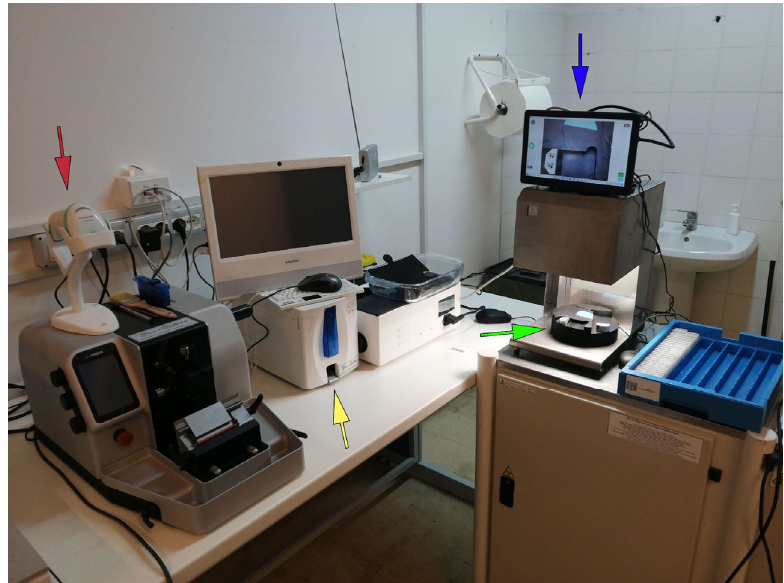
Figure 7 . An example of a sectioning station. The technician can identify the block through a barcode reader (red arrow), entering the LIS page of the case and printing the related glass slides with a laser printer (yellow arrow). After sectioning, the technician can directly scan the cut surface positioning the block on the dedicated space in the BlocDoc instrument (green arrow), with the possibility to assess the preview of the obtained image (blue arrow).